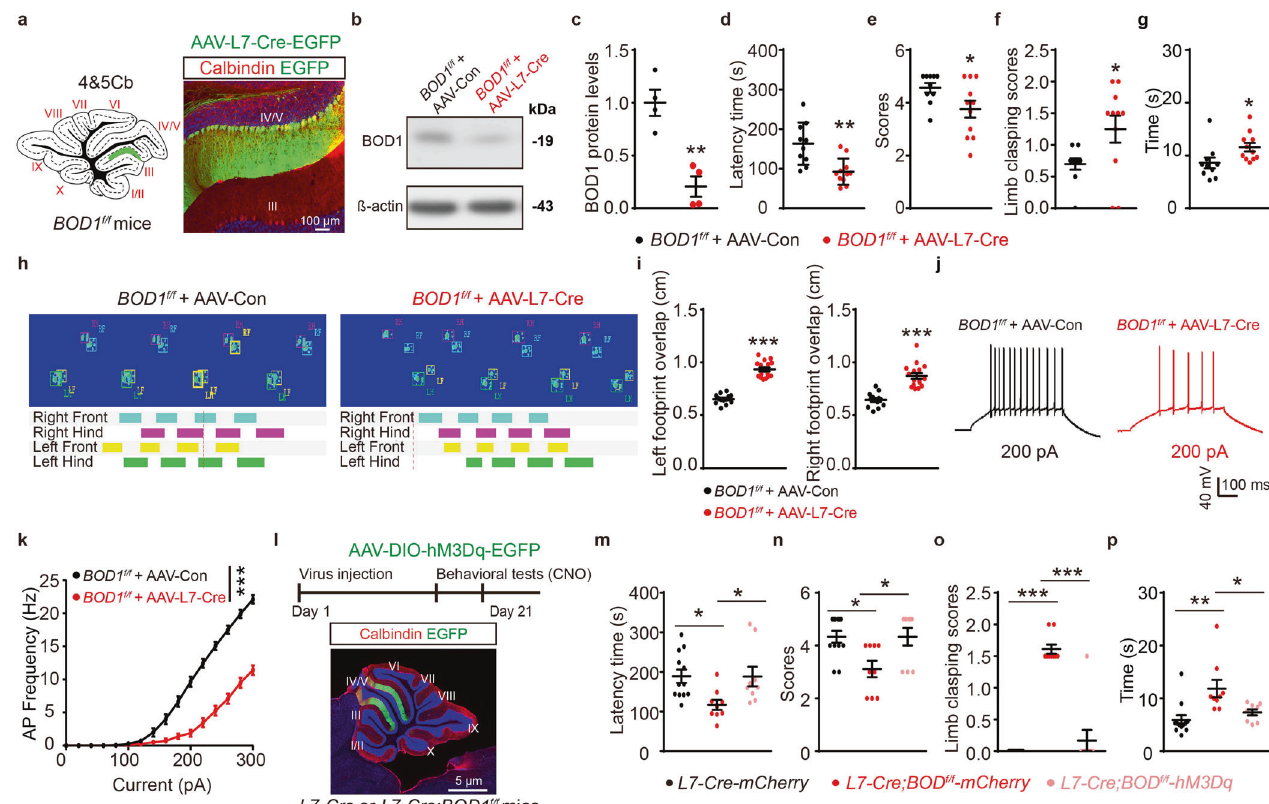
Fig. 4 BOD1 regulates the function of cerebellar IV/V lobe PCs → FN CaMKII α + circuit. a Schematic injection of AAV-L7-Con-EGFP or AAV-L7-Cre- EGFP and validation of EGFP in PCs of IV/V lobe. b , c Representative ( b ) and quanti fi cation ( c ) of immunoblot analysis of BOD1 protein levels in the cerebellar vermis of AAV-L7-Con-EGFP or AAV-L7-Cre-EGFP injected to IV/V lobe in BOD1 f/f mice ( n = 3 mice per group; ** P < 0.01; unpaired two-tailed Student ’ s t test). d – g Behavioral effects of BOD1 de fi cit in IV/V lobe. After injection of AAV-L7-Con-EGFP or AAV-L7-Cre-EGFP to IV/V lobe in BOD1 f/f mice, the ataxia-related behaviors were performed ( n = 10, 11 mice per group; * P < 0.05; ** P < 0.01; unpaired two-tailed Student ’ s t test). h , i Representative images of Gait footprint ( h ) and quanti fi cation of the left and right footprint overlap for Gait footprint ( i ) ( n = 13, 16 mice per group; *** P < 0.001; unpaired two-tailed Student ’ s t test). j Representative AP fi ring of PCs evoked by current injections at 200 pA. k Quanti fi cation of the AP frequency by current injections from 0 to 300 pA (stepped by 20 pA) in AAV-L7-Con-EGFP-injected or AAV- L7-Cre-EGFP-injected to IV/V lobe in BOD1 f/f mice ( n = 24 cells from three mice per group; *** P < 0.001; two-way ANOVA followed by Turkey ’ s multiple comparisons test). l Injection of AAV-DIO-EGFP or AAV-DIO-hM3Dq-EGFP in IV/V lobe of L7-Cre and L7-Cre; BOD1 f/f mice and representative images of EGFP in PCs layer. m – p After intraperitoneal injection of CNO (1 mg/kg) to mice, the ataxia-related behaviors were performed in AAV-DIO-EGFP or AAV-DIO-hM3Dq-EGFP-injected L7-Cre and L7-Cre; BOD1 f/f mice ( n = 12, 9, 9 mice per group; * P < 0.05; ** P < 0.01; *** P < 0.001; one-way ANOVA followed by Turkey ’ s multiple comparisons test). The data are presented as means ± (Supplementary Fig. 7f, g). The lack of change in the paired-pulse ratio (PPR) of evoked EPSCs and PTX-sensitive mIPSCs in PCs of L7- Cre; BOD1 f/f mice suggested that the decreased mEPSCs frequency was not due to a decrease in the presynaptic release probability (Supplementary Fig. 7h – l). To determine whether the dendritic morphology and spine density contribute to decreased synaptic transmission, we injected SFV-EGFP into lobules IV/V of mice (Supplementary Fig. 7m). A signi fi cant decrease was observed in the dendritic intersection of PCs in BOD1 -de fi ciency mice (Supplementary Fig. 7n, o). Imaging spines between groups (Supplementary Fig. 7p – t), suggesting that BOD1 deletion selectively decreased the number of mature dendritic spines in PCs. Transcriptional regulation cues of spine and dendrite morphogenesis by BOD1 We next uncover the molecular mechanism that links BOD1 de fi ciency to the loss of spine and dendrite. We expressed EGFP under a L7 promoter in PCs by injecting AAV-L7-EGFP into the IV/V lobe of L7-Cre and L7-Cre; BOD1 f/f mice (Fig. 5a). We collected